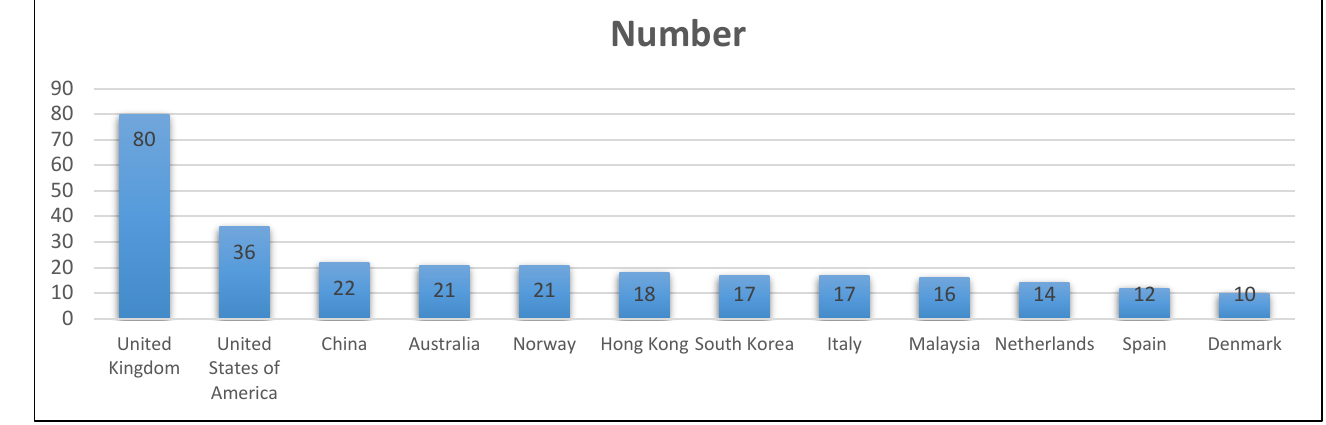
Figure 2: Document by Country or Territory.